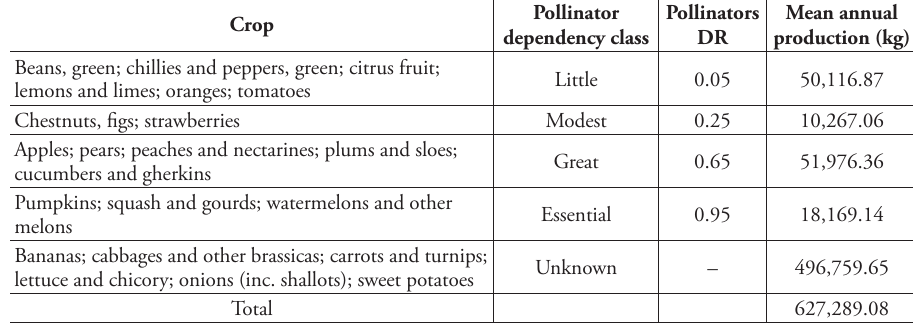
Table 8. Mean annual production values of crops with different pollinator dependency categories, for the period from 2011 to 2015.